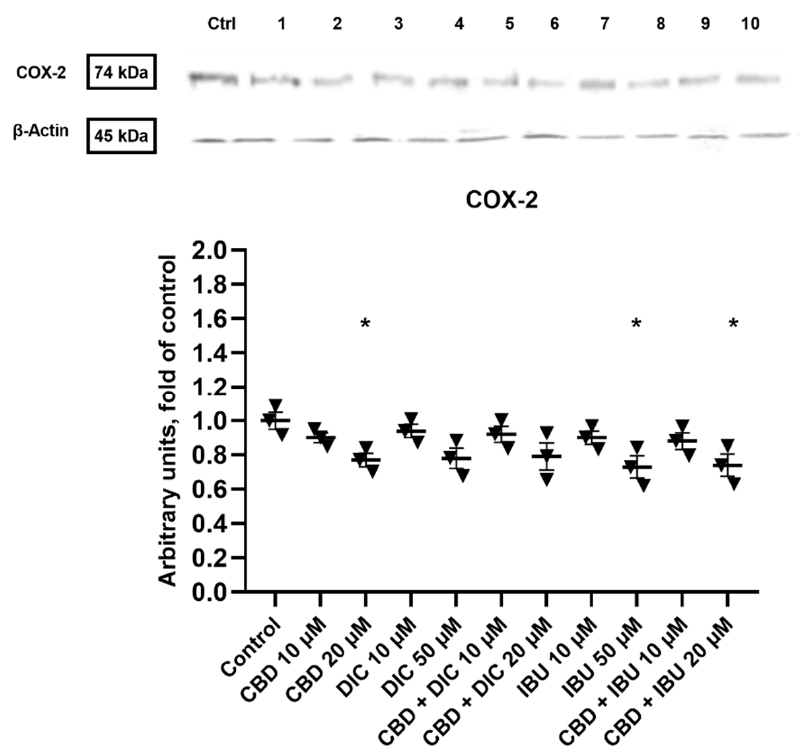
Figure 7. The effect of CBD and its combinations with DIC and IBU on the level of COX-2 protein in A431 cells. Representative Western blots are presented above the graph. The numerical code follows the order of compounds presented in charts, i.e., Ctrl —Control, 1 —CBD 10 µ M, 2 —CBD 20 µ M, 3 —DIC 10, 4 DIC—50 µ M, 5 —CBD + DIC 10 µ M, 6 —CBC + DIC 20 µ M, 7 —IBU 10 µ M, 8 —IBU 50 µ M, 9 —CBD + IBU 10 µ M, 10 —CBD + IBU 20 µ M. The values (mean ± SEM) were calculated as a relative change in the protein level compared to control cells from three separate experiments. Mean values significantly different from the control group are indicated with * p < 0.05.